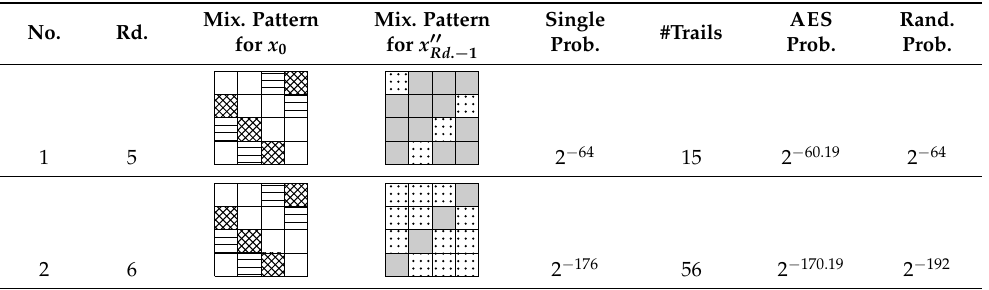
Table 1. Mixture distinguishers covering 5- and 6-round AES.